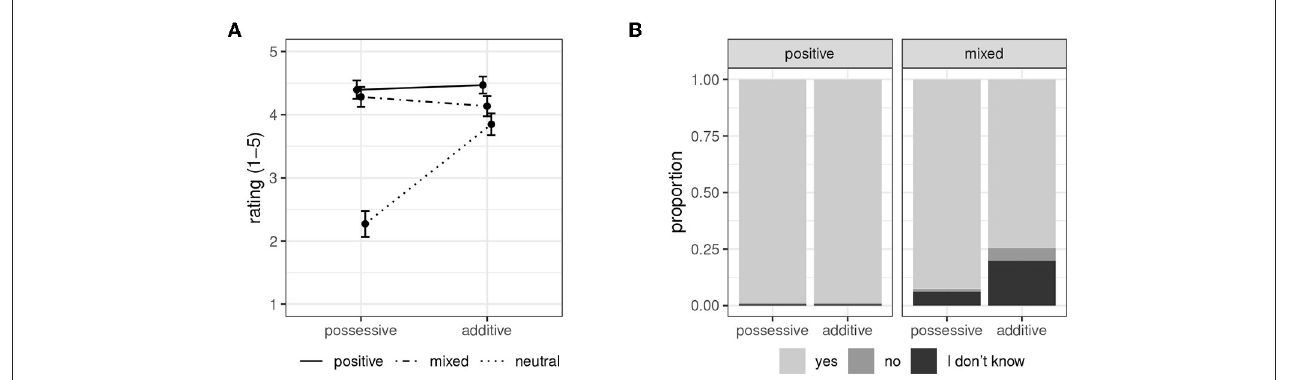
FIGURE 2 | Results of the experiment reported in Grubic (forthcoming): felicity ratings with 95% confidence intervals (A) and answer proportions (B) .